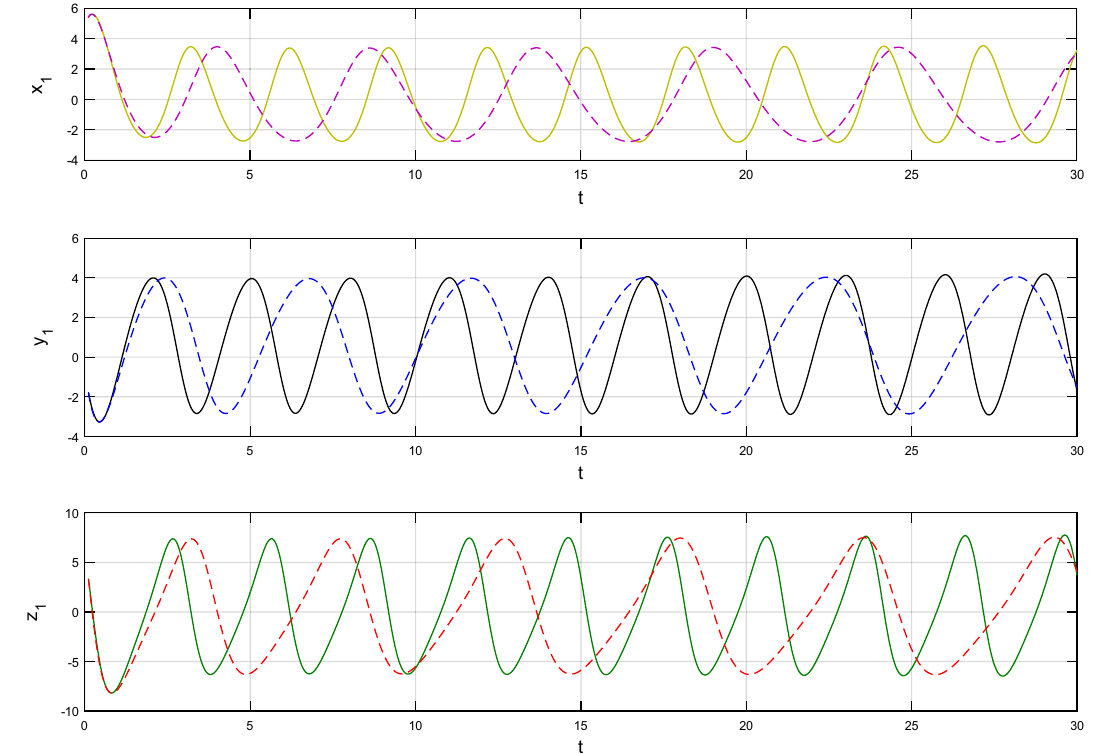
Figure 13. An analysis of the chaotic attractors for this case when β = 1 (line) and β = 0.85